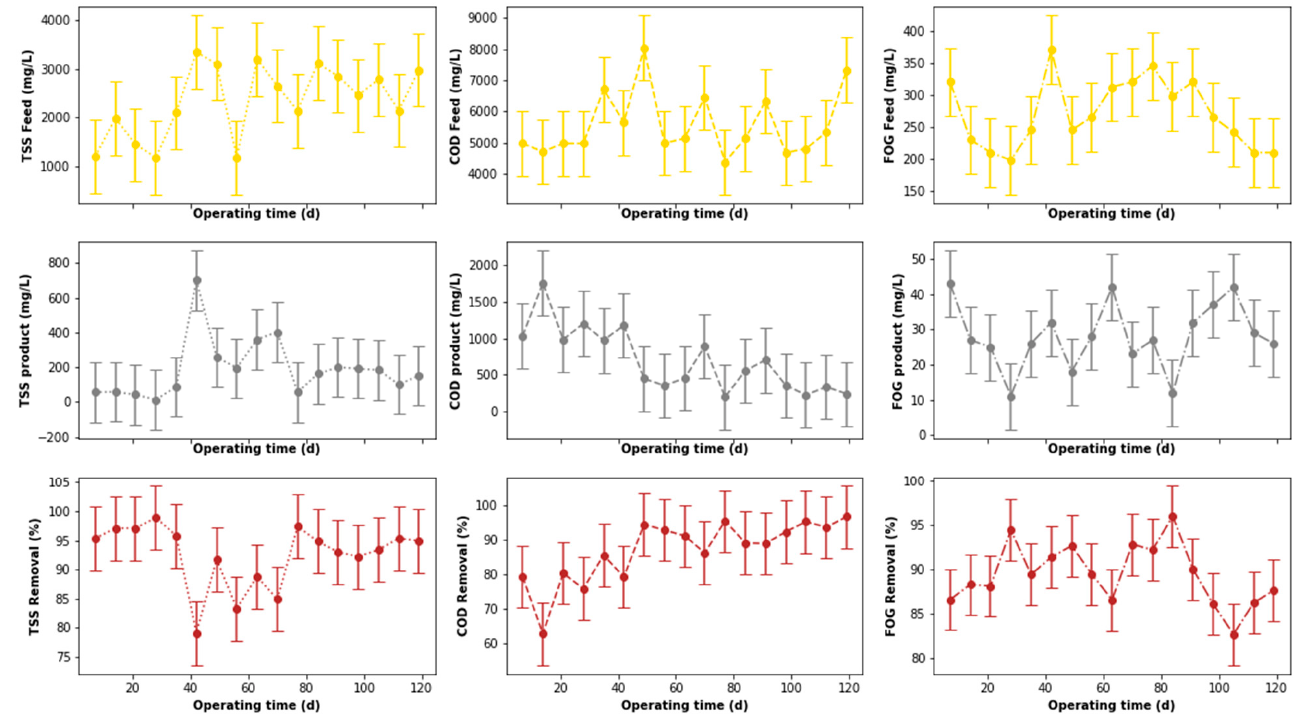
Membranes 2021 , 11 , x FOR PEER REVIEW Figure 12. Performance of PSW DEGBR before outliers’ detection and replacement.